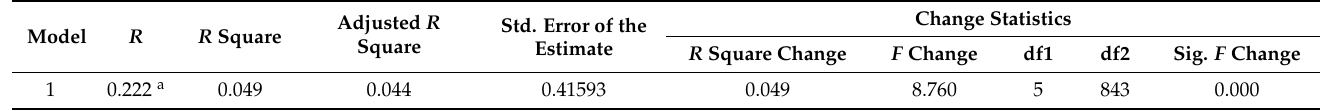
Table 3. Linear regression model.